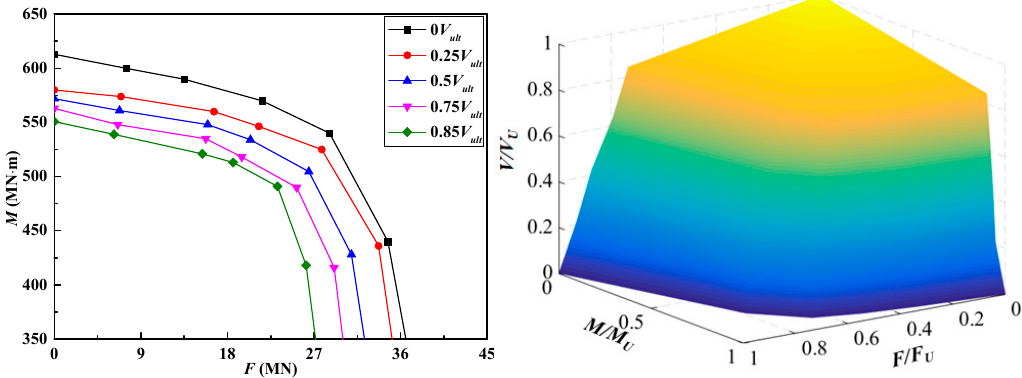
Figure 23. Failure envelope in V–H–T load space under different vertical forces.